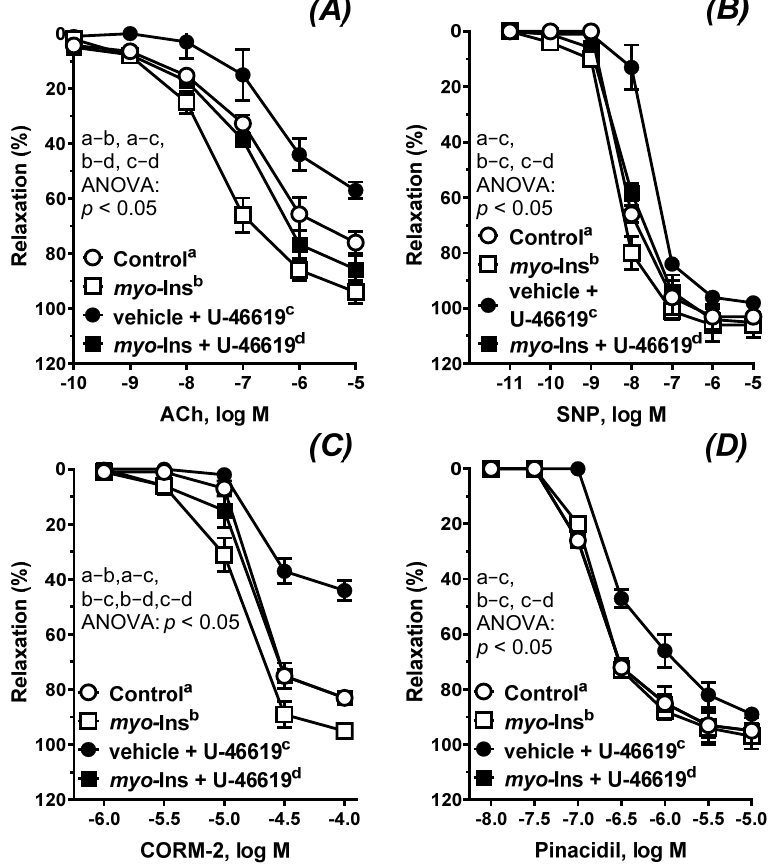
Figure 2. The cumulative concentration-response curves to acetylcholine ( A ), sodium nitroprusside ( B ), carbon monoxide releasing molecule ( C ), and pinacidil ( D ) in the isolated thoracic arteries of the control (a), myo -inositol only (b), vehicle plus U-46619 (c), myo -inositol plus U-46619 (d). Aortic rings were pre-incubated with either myo -inositol (1 µ M, 60 min) for groups b and d or vehicle (KHS)—groups a and c. Next, aortic rings were subjected to U-46619 (0.1 nM, 60 min)—groups c and d. Results (means ± SEM, n = 6) are expressed as a percentage of inhibition of the contraction induced by noradrenaline (0.1 µ M), p < 0.05, two-way ANOVA with Tukey’s multiple comparisons test. Abbreviations: ACh, acetylcholine; SNP, sodium nitroprusside; CORM-2, carbon monoxide releasing molecule.